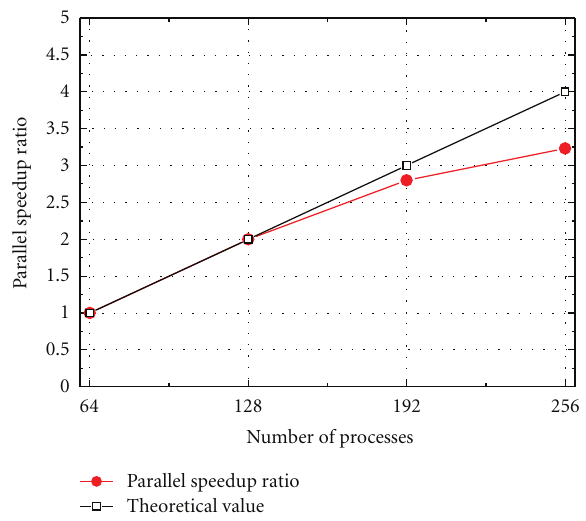
Figure 10: Parallel e ffi ciencies for the simulation of Mirage aircraft.